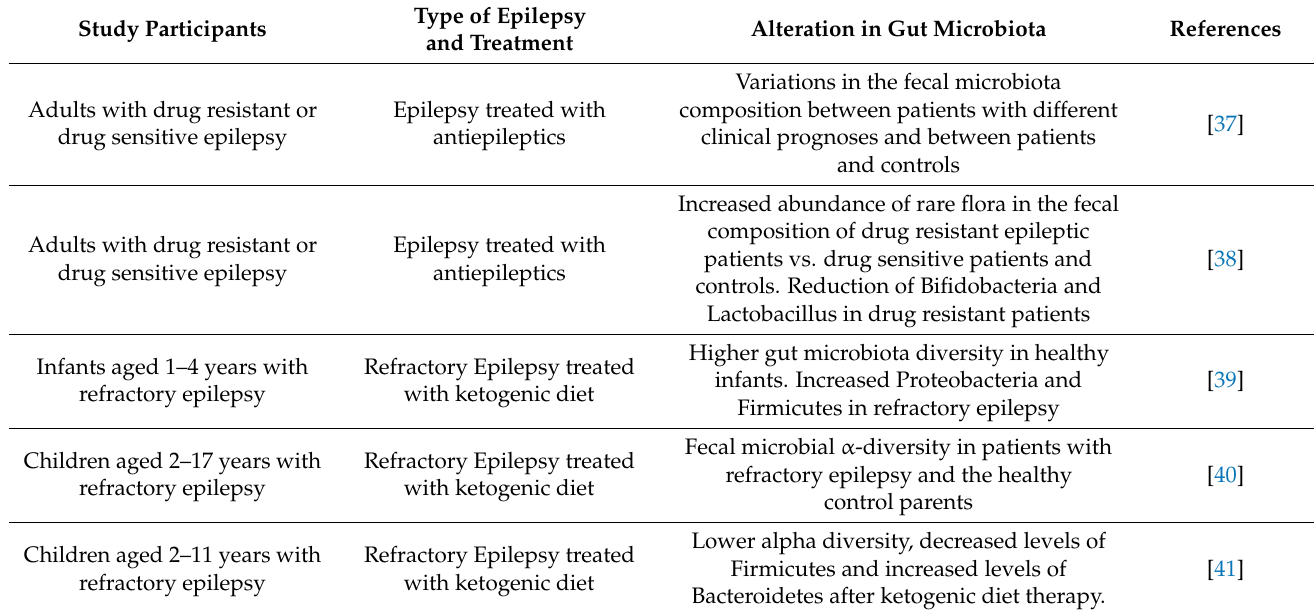
Table 1. Alterations in gut microbiota composition in subjects affected by epilepsy treated with antiepileptic drugs and/or ketogenic